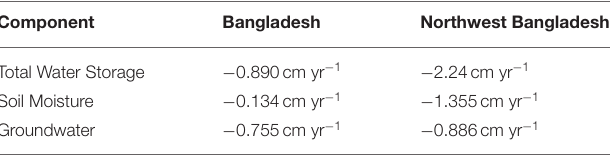
TABLE 1 | Trends for water storage components in Bangladesh and Northwest Bangladesh. Component